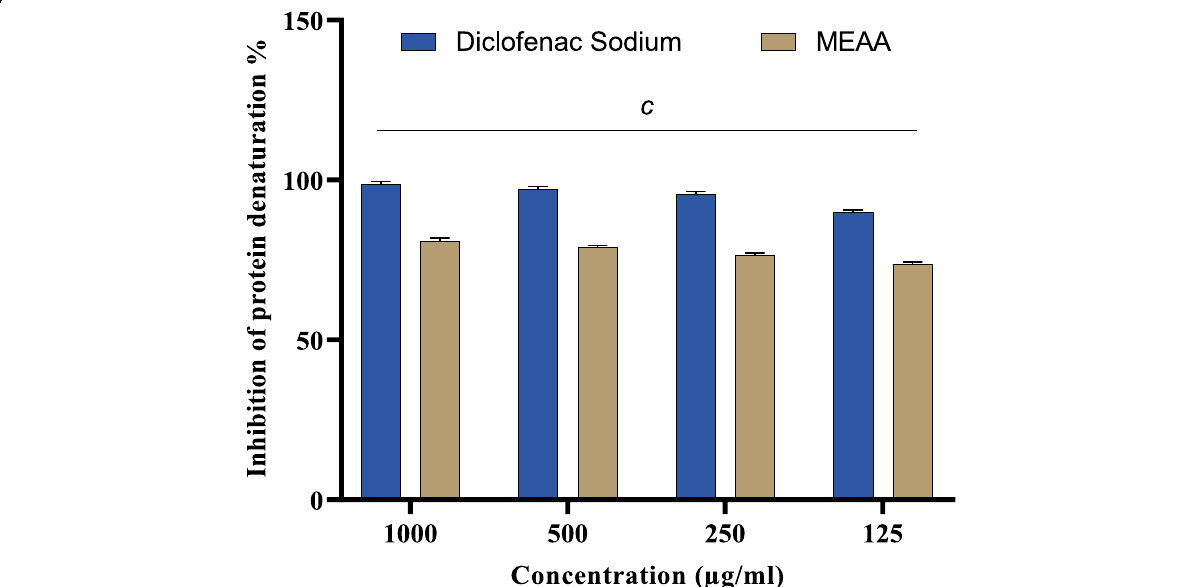
Fig. 3 Percentages of bovine serum albumin protein denaturation by methanol extract of methanol leaves extract of A . auriculiformis (MEAA) and standard drug diclofenac sodium. Values are mean ± SEM ( n = 3). c p < 0.001, significantly different from control followed by Dunnett ’ s